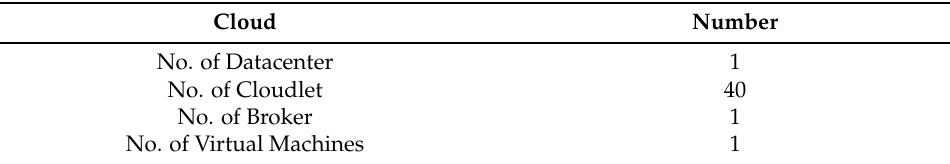
Table 5. Configuration of Simulated Cloud.